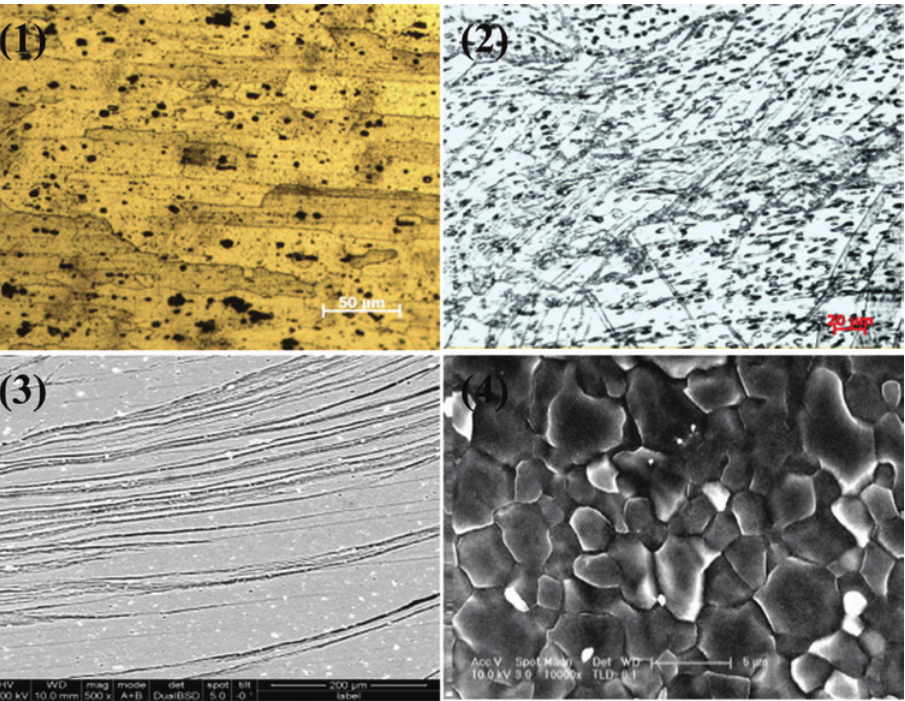
Figure 10: (1) Photomicrograph of Al 2024-T3 base metal. Average grain size = 160 × 32 μ m (2) Photomicrograph of AZ31B-O base metal. Average grain size = 50 × 12 μ m (3) SEM image of Al 2024-T3 side of WN. Average grain size = 60 × 22 μ m (4) SEM image of AZ31B-O side of WN. Average grain size = 2.2 μ m. Photomicrographs 1 and 2 are obtained from samples, which were used to obtain SEM images 3 and 4